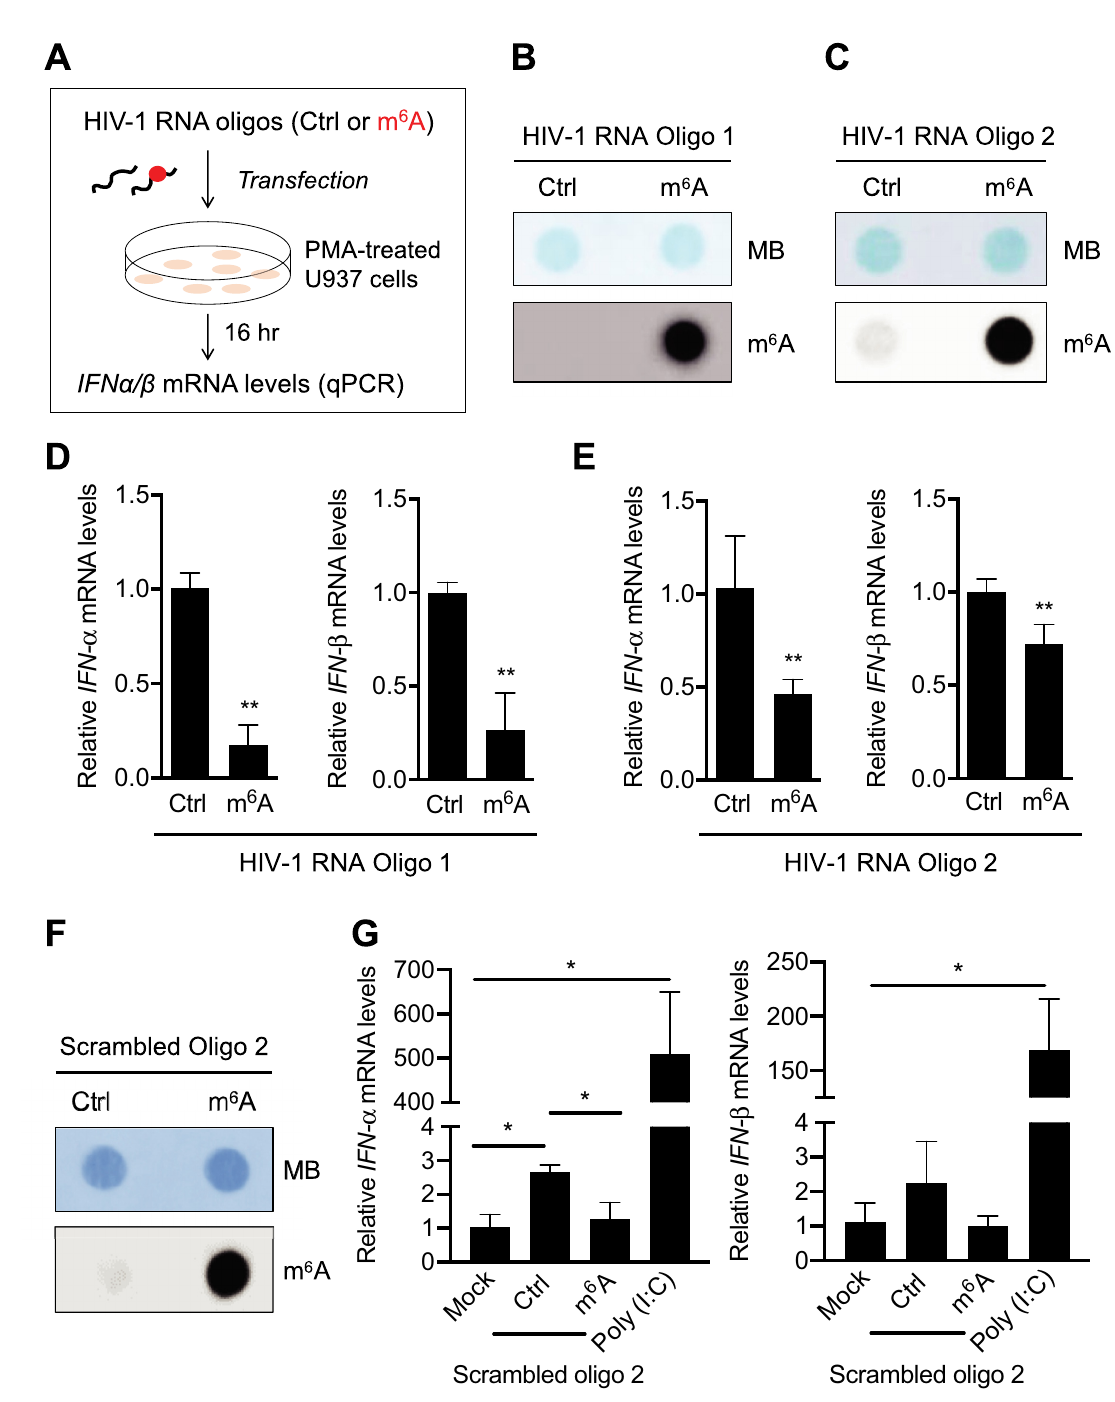
Fig 1. A single m 6 A modification of HIV-1-derived RNA oligos inhibits IFN-I induction in differentiated U937 cells. (A) A schematic of the experimental approach. (B) HIV-1 5 0 UTR (nt. 235–281) RNA oligo 1 (50 ng), (C) HIV-1 5 0 UTR (nt. 176–217) RNA oligo 2 (200